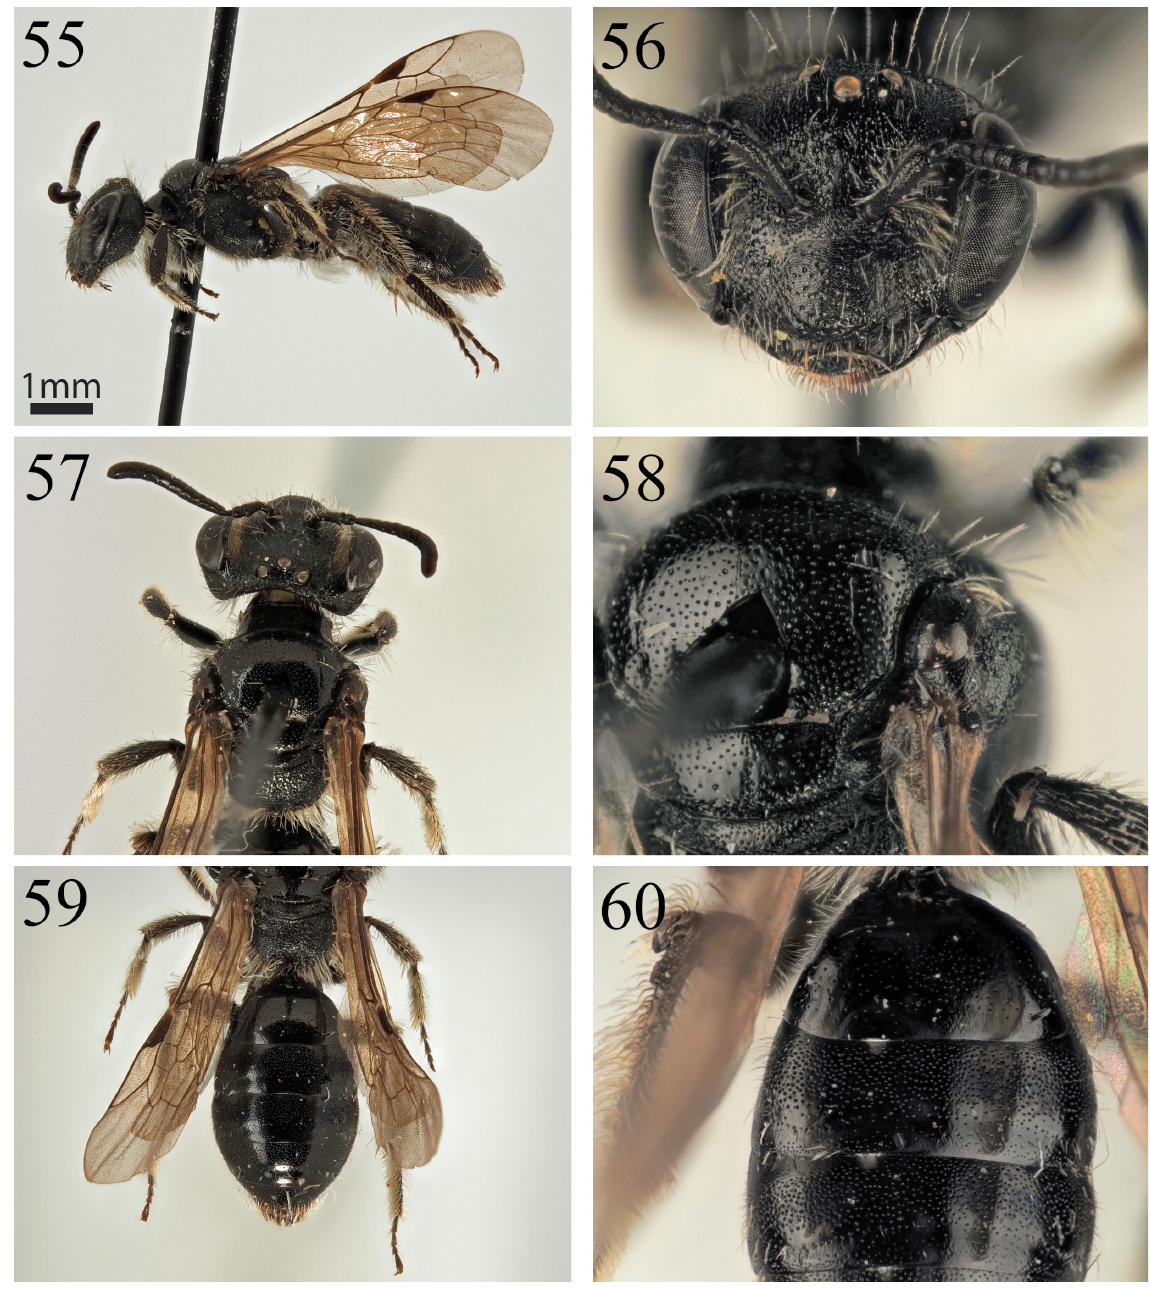
Figs 55–60. Andrena obsidiana Wood sp. nov., ♀ (OÖLM). 55 . Profile. 56 . Face. 57 . Dorsum. 58 . Scutum, detail. 59 . Terga. 60 . Terga,